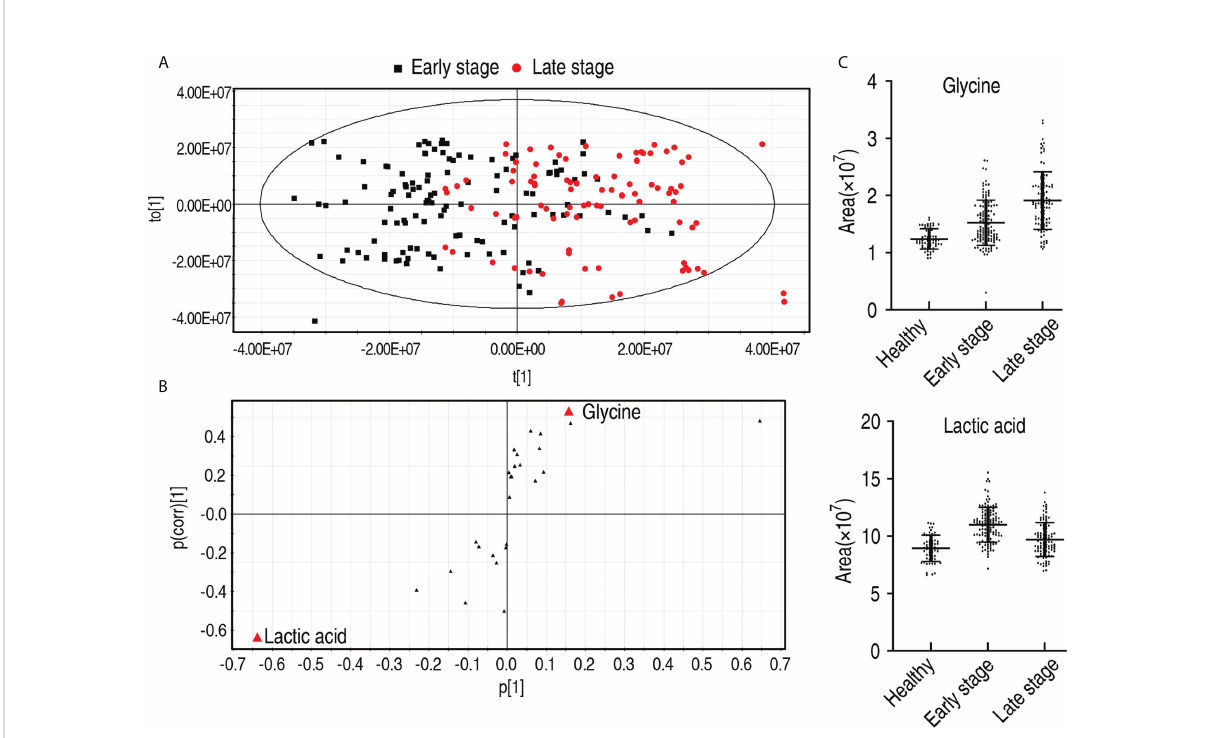
FIGURE 7 Identi fi cation for biomarkers in the early and late stages of patients with esophageal cancer. (A) OPLS-DA of stage 0 – II and stage III – IV esophageal cancer. Each dot represents one technical repeat in the plot. (B) S-plot is generated from OPLS-DA. The triangle represents metabolites and candidate biomarkers are highlight in red. (C) Abundance of biomarkers. Results are displayed as mean ±